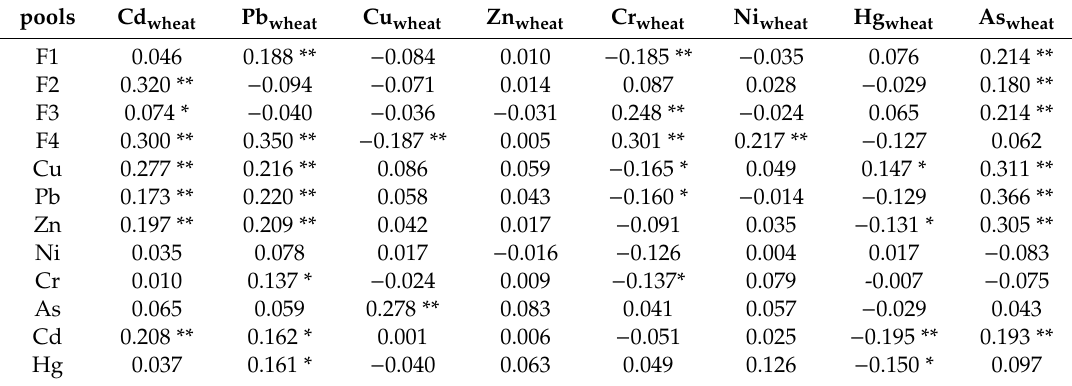
Table 5. The comprehensive correlation of the pools of trace metal(loid)s and the physical–chemical properties in soil and